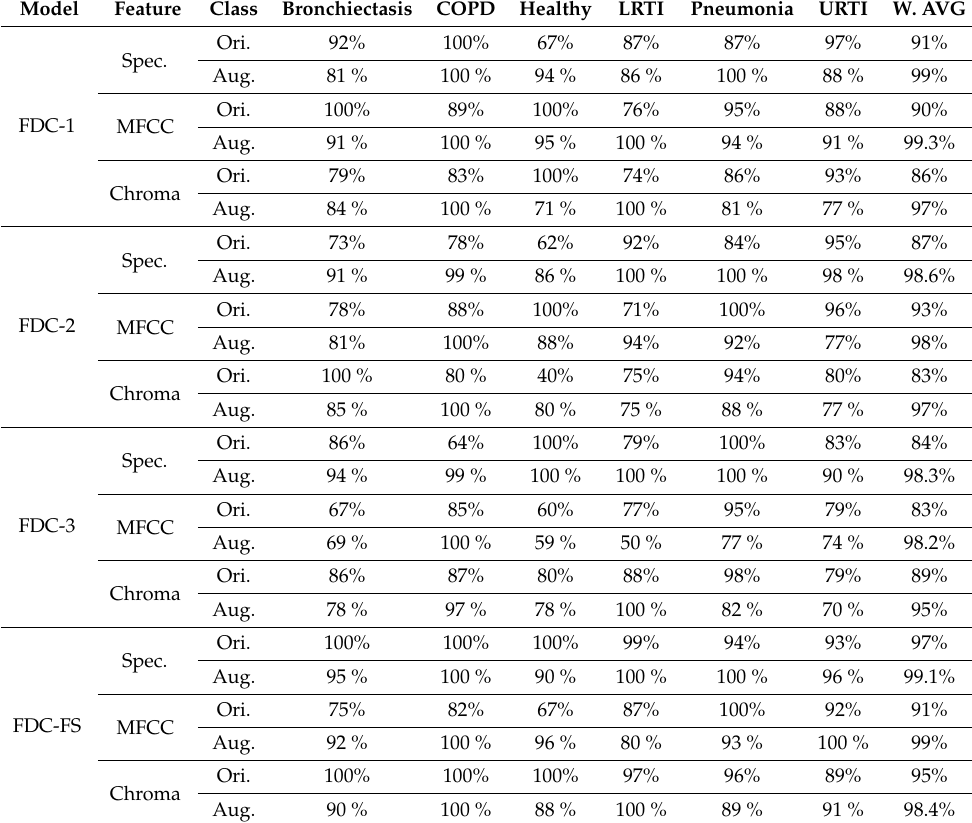
Table 10. Class Wise Accuracy for Lung Condition Detection.